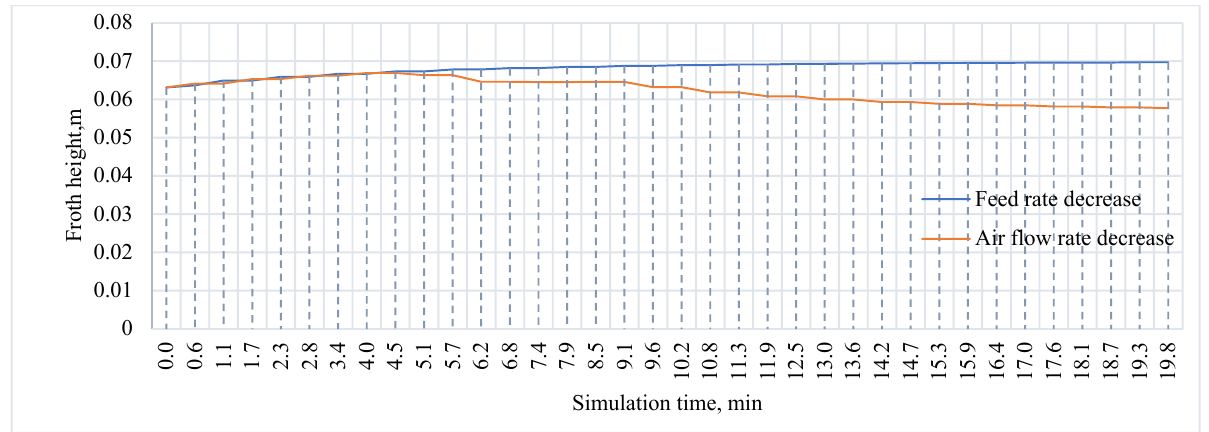
Figure 12. Froth height values in the simulation.